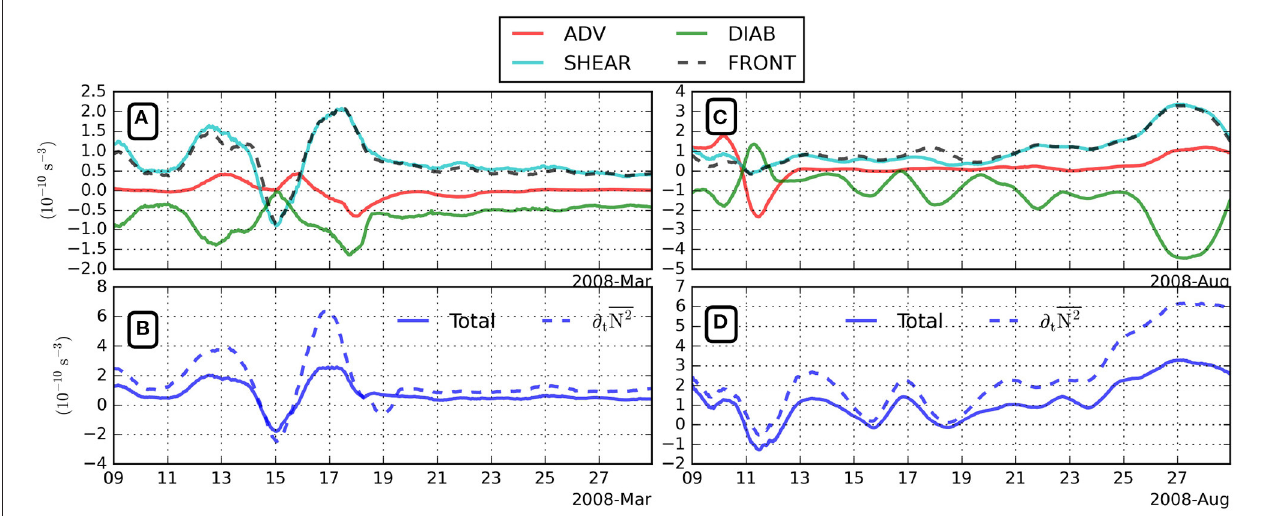
FIGURE 15 | The advective (Ja, solid red), shear (Jf, solid light blue), diabatic (Jd, solid green) PV fluxes and Frontogenesis term (FRONT, dashed black) in March (A) and in August (C) 2008. The stratification time rate (dashed blue) and the total term ( ∂ t N 2 + bvp |